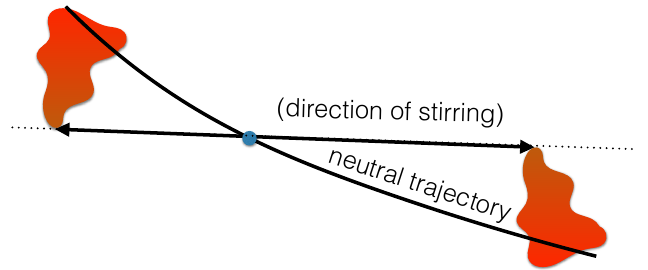
Figure 1. Schematics adapted and modified from Figure 1 of [6], intended to be a: “Sketch of a central seawater parcel being moved adiabatically and without change in its salinity to either the right or the left of its original position in a direction that is not neutral. When the parcel is then released it feels a vertical buoyant force and begins to move vertically (upward on the left and downward on the right) toward its original “isopycnal”". The sentence (direction of stirring) was added to the original